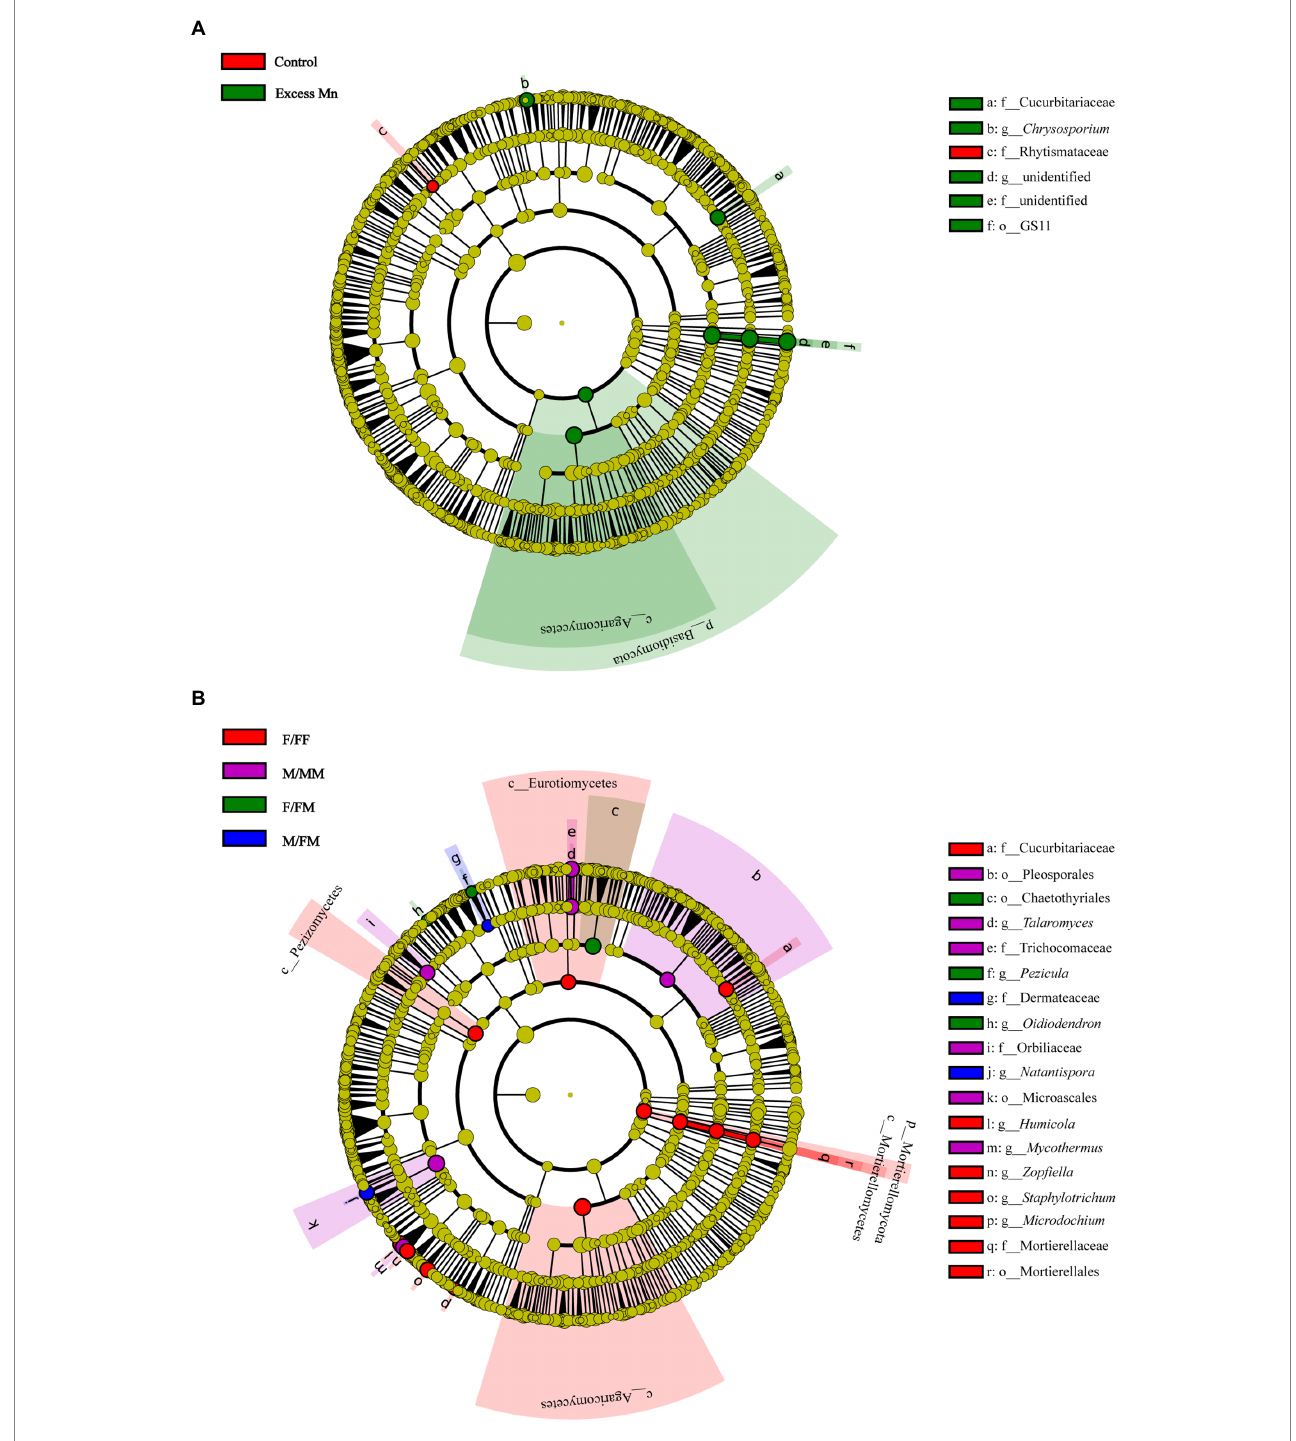
FIGURE 3 Fungal taxa with different abundance changes between control and Mn treatment, irrespective of sexual competition patterns (A) , and between sexual competition patterns, irrespective of Mn treatment as detected by the linear discriminant analysis effect size (LEfSe) analysis (B) . Only taxa with LDA over 5.5 are shown. The node color indicates taxa enriched under different treatment and interaction